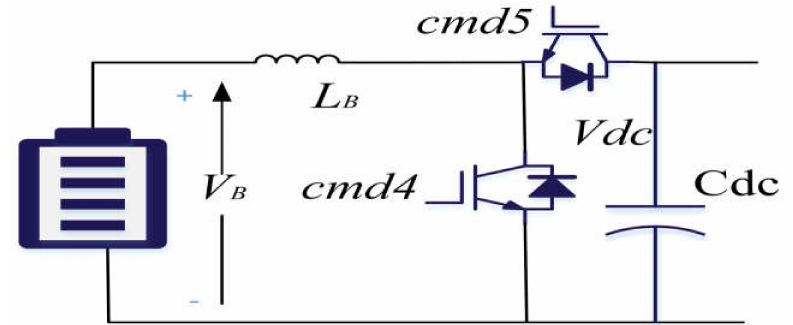
Figure 4. Structure of the bidirectional DC-DC